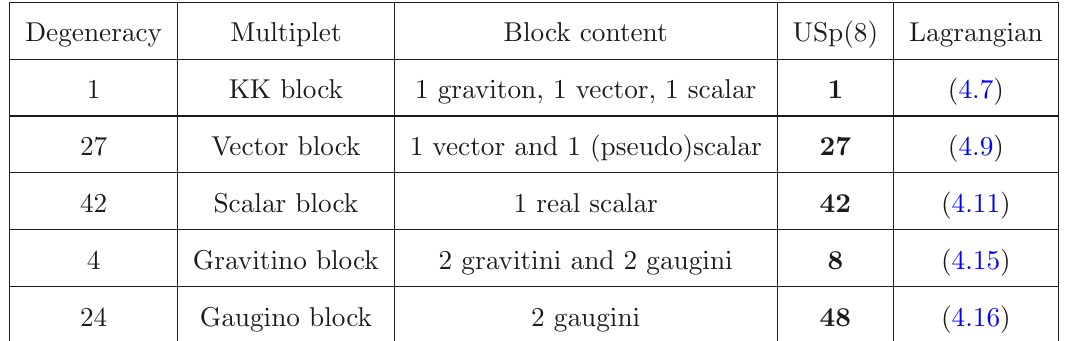
= 8 supergravity around the KK black N